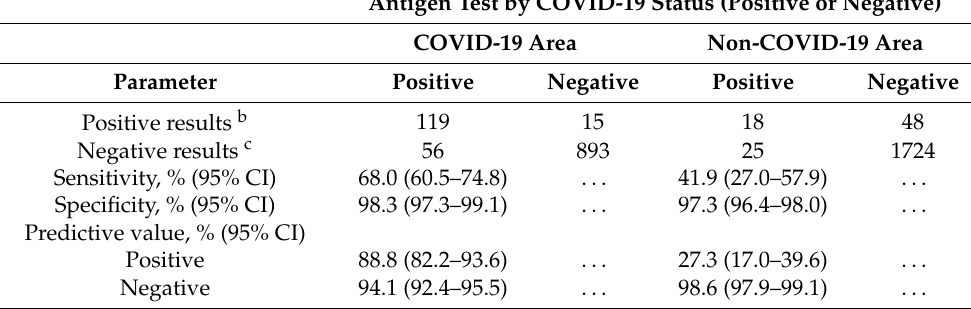
Table 1. Antigen test performance according to the RT-PCR positivity or negativity used to determine the positive or negative COVID-19 status a